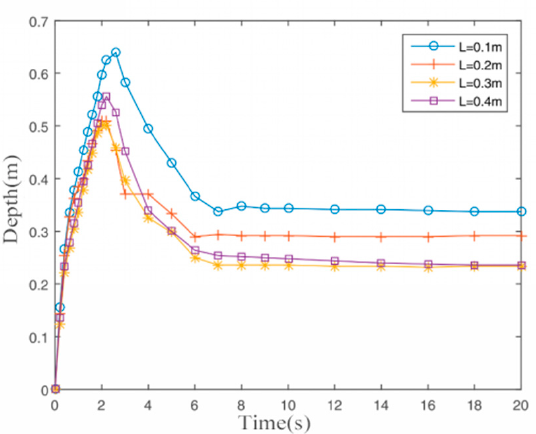
Figure 15. The relationship between scour depth and time at different jet spacing values.